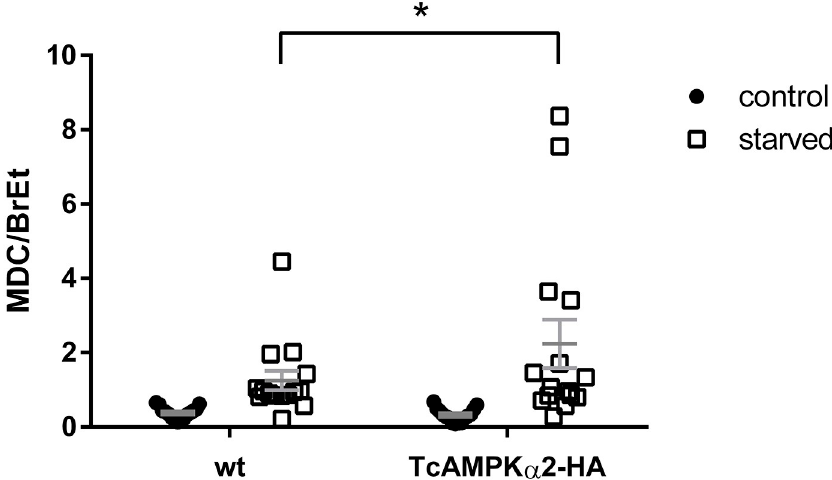
Fig 6. TcAMPK α 2 overexpressing epimastigotes have an increased autophagic capacity. MDC incorporation was measured for wild type and overexpressing epimastigotes after 17 h incubation in either LIT medium (control) or PBS (starved). MDC values were normalized to Ethidium Bromide (BrEt) incorporation. MDC/BrEt ratio is expressed in arbitrary units. A t-test analysis of the starvation condition between the two strains shows a significant difference (n = 15). There were no significant differences in the control conditions. Error bars represent the Standard Error of the